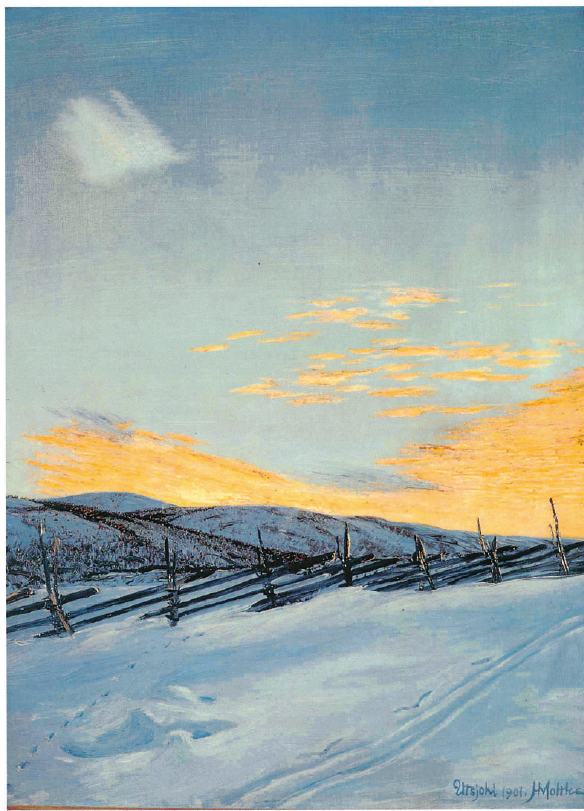
Fig. 1. Polar stratospheric cloud, January 5, 1901, 1215 p.m., Utsjoki, Finland. Oil painting by Harald